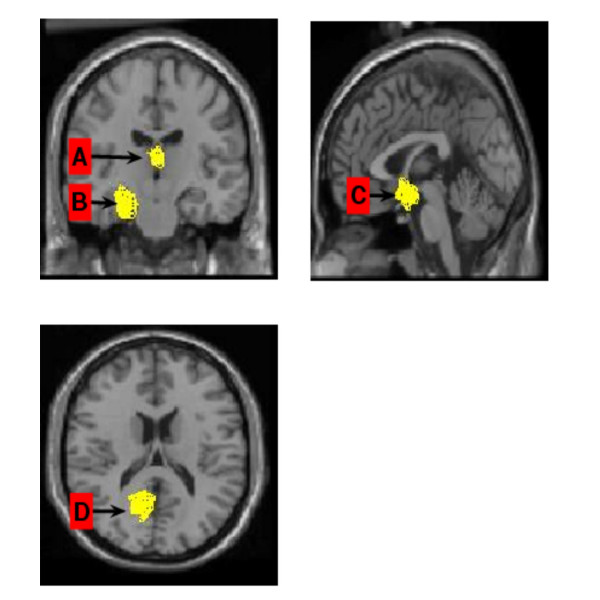
The hot-spots are detected by HOTTOR algorithm in fMRI data (from [13]). Three slices are shown at different orientations and identifying significant altered activity in (A) the medial thalamus, (B) the right amygdala, (C) the head of the caudate nucleus and (D) the right retrosplenial cortex.